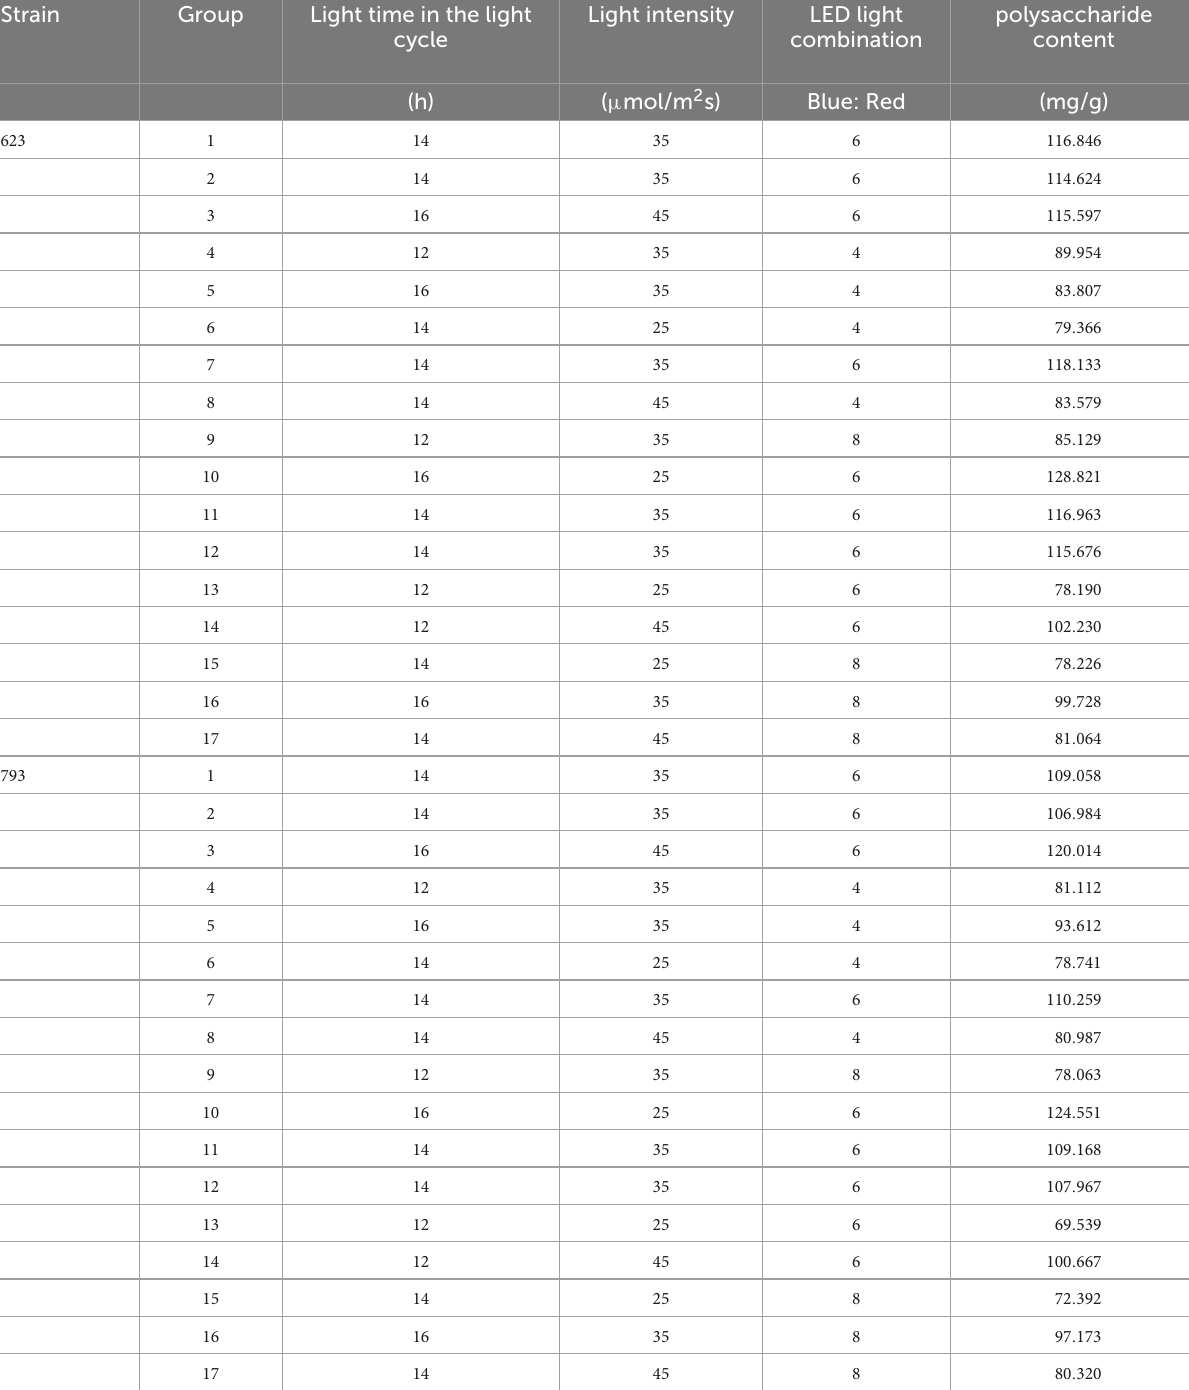
TABLE 6 Response surface experimental design and results of polysaccharide accumulation of Arthrospira platensis OUC623 and A. platensis OUC793. Strain Group Light time in the light